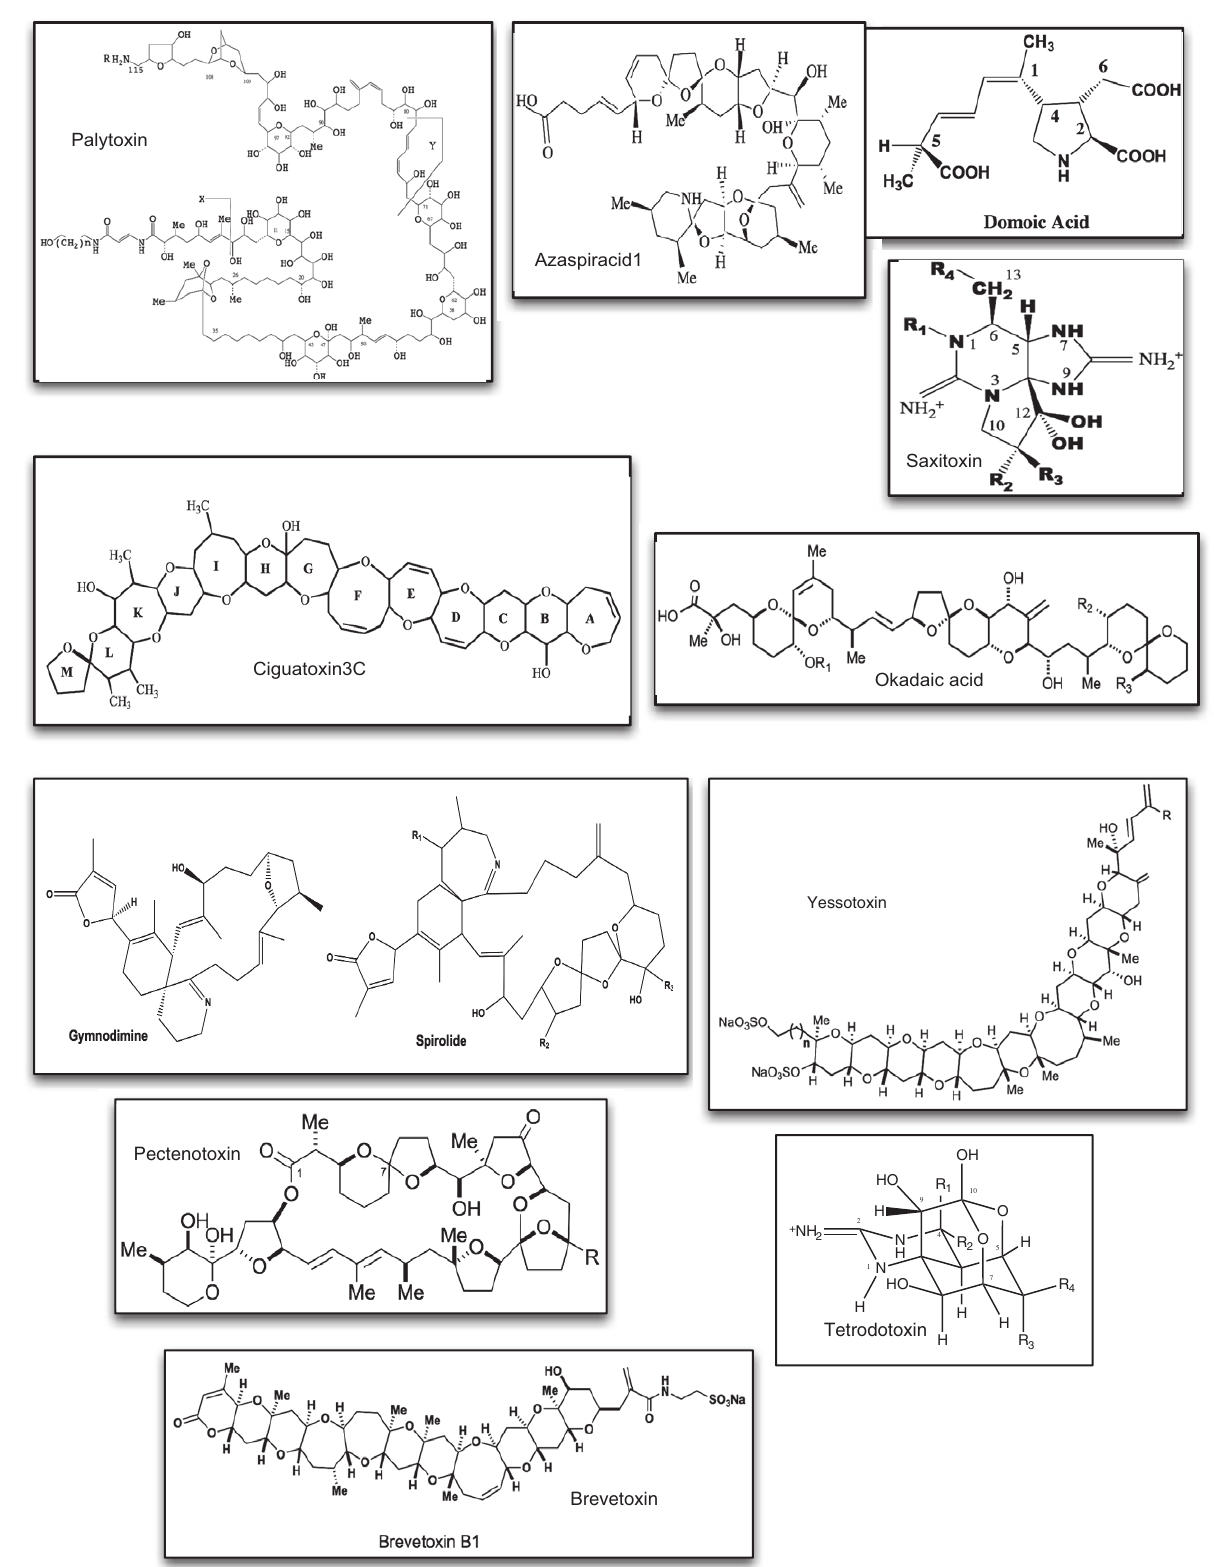
Figure 1 Structures of representative